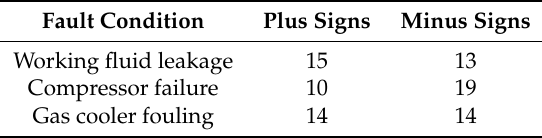
Table 11. Degree of